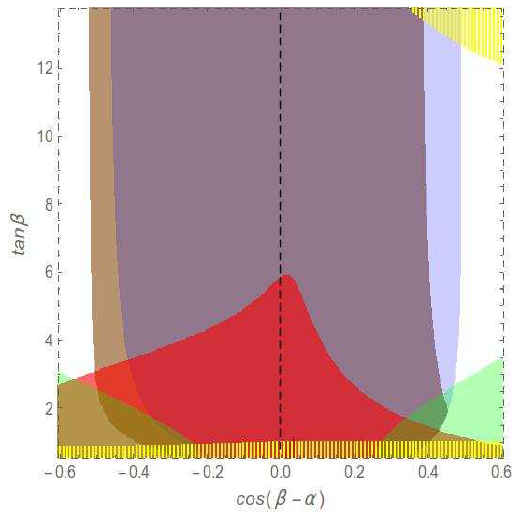
Figure 3 . Allowed region with a non-zero value of the Wilson coefficient of ϕ 2 D 2 X type operator, c ϕW = 0 . 01, with all other Wilson coefficients being zero. Colour coding is the same as in figure 1. −